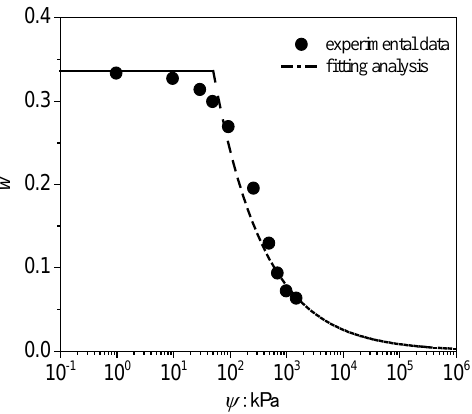
Figure 6. Determination of the values of fractal dimension at reference state through plotting experimental data of ln w against (–ln ψ ) for Hefei expansive soil with e 0 = 0.915.